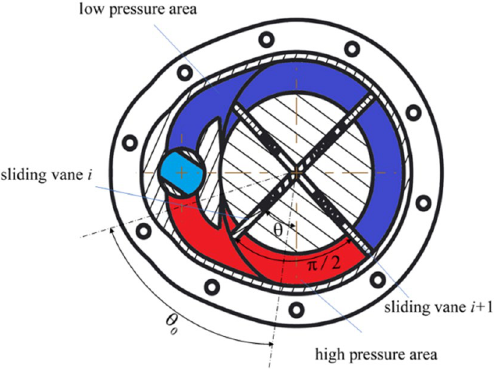
Figure 5. Sketch map of the fluid pressure. (Figure is created with the software Creo/parametric 2.0 and modified with the drawing software integrated in the Win 10 operation